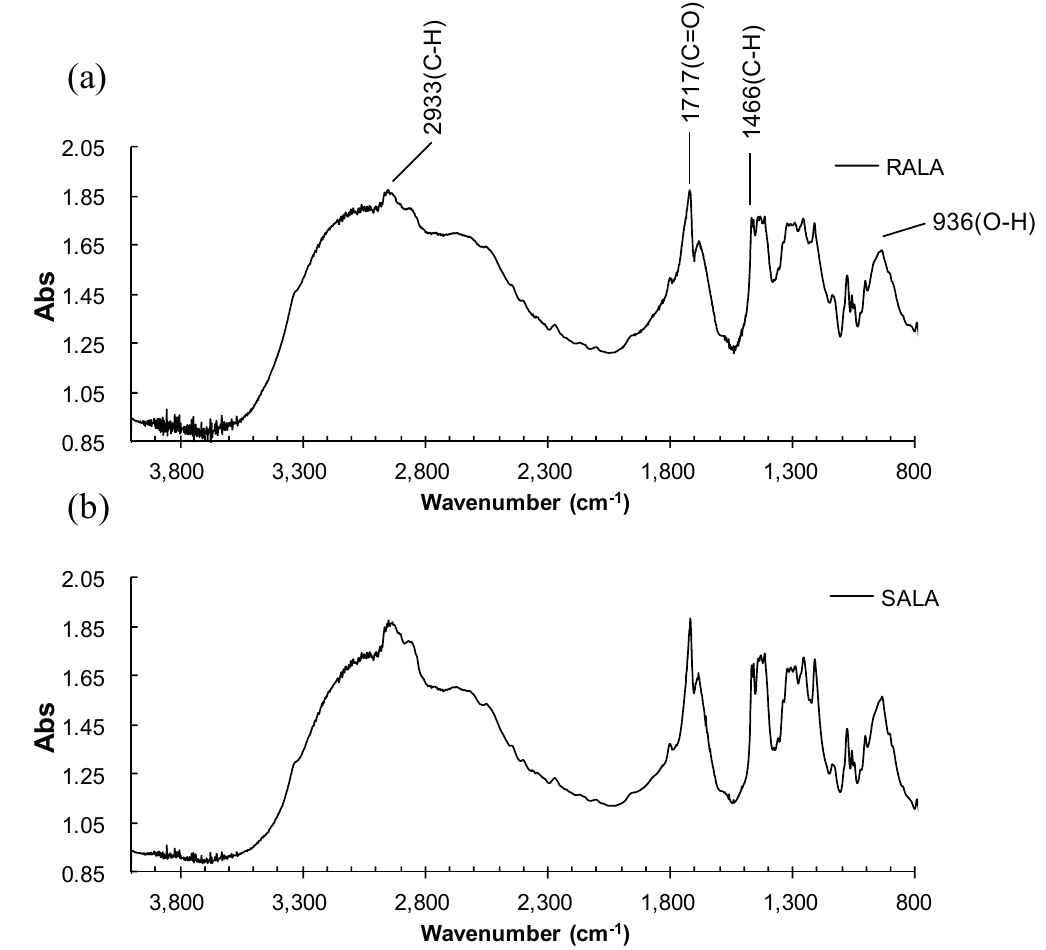
Figure 3. Microscopic Fourier transform infrared (FT-IR) spectra of ( a ) RALA and ( b )